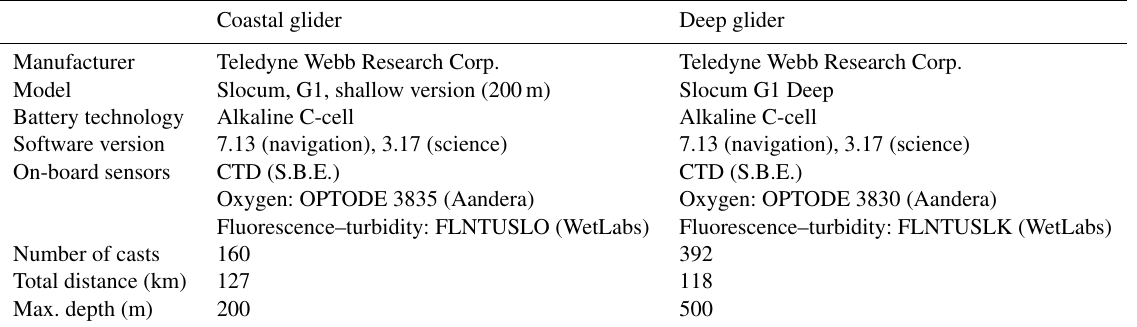
Figure 7. Temperature (a) and salinity (b) measured by the two gliders. The approximate front position at the surface is shown as a dashed grey line. Table 3. Characteristics of the